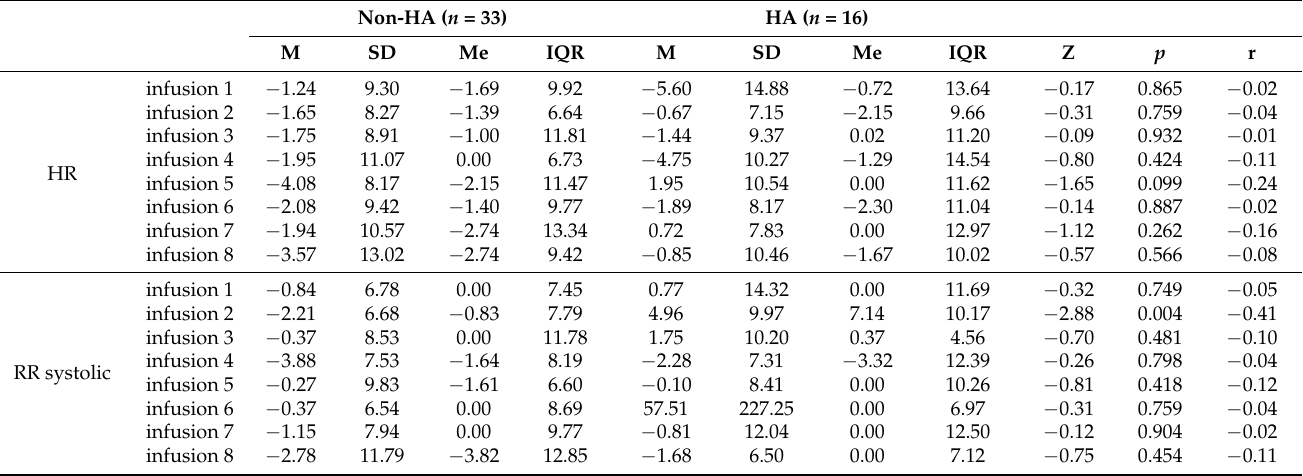
Table 2. Using the Mann–Whitney U test, the mean-term blunt changes in HR and RR were compared with each other due to the use of a given type of